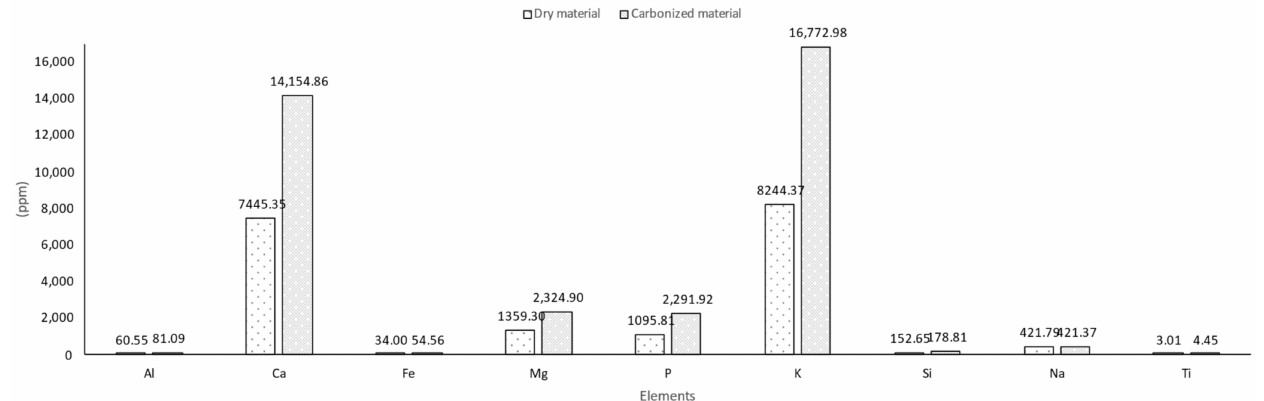
Figure 8. Evolution of the contents of major elements after the carbonization of vine pruning.